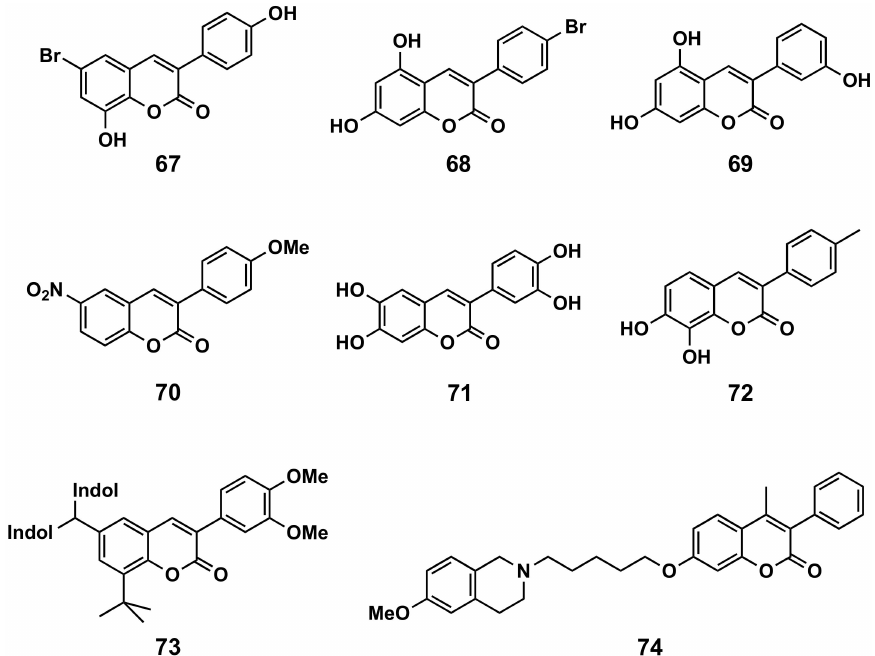
Figure 22. 3-Phenylcoumarins as enzymatic inhibitors: tyrosinase ( 67 and 68 ), xanthine oxidase ( 69 and 70 ), glutathione S-transferase ( 71 ), HMG-CoA reductase ( 72 and 73 ) and P-glycoprotein ( 74